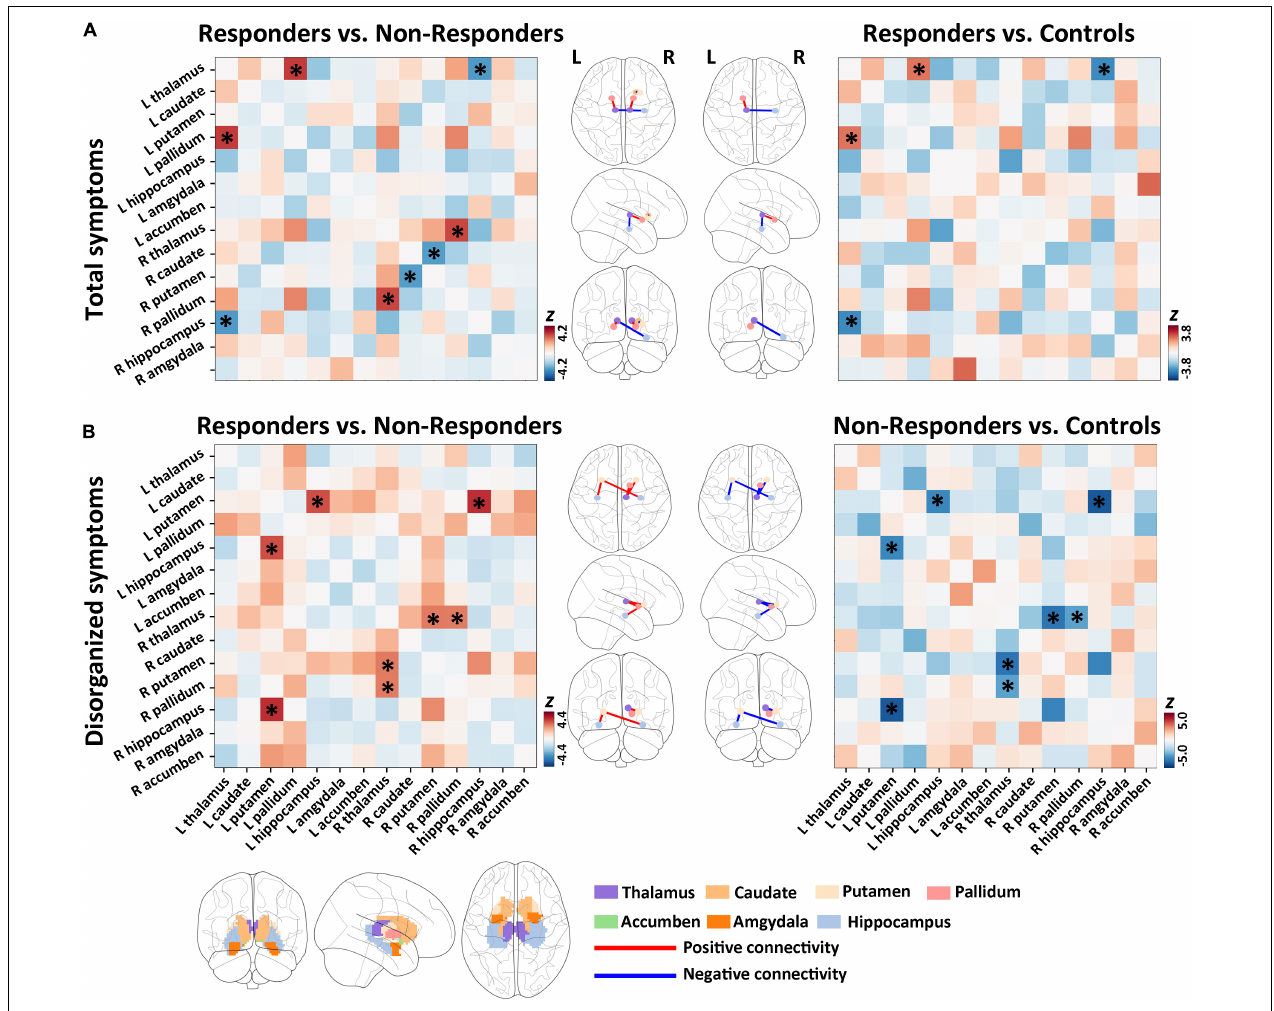
FIGURE 2 | Group differences of baseline subcortical structural covariance for total and disorganized symptoms. (A) In the total symptom dimension, we detected significant differences in baseline structural covariance in the hippocampus–thalamus–pallidum–caudate–putamen pathway between responders and non-responders. (B) For disorganized symptoms, significant differences in baseline structural covariant connections were found in the putamen–hippocampus–pallidum–thalamus circuit between responders and non-responders.